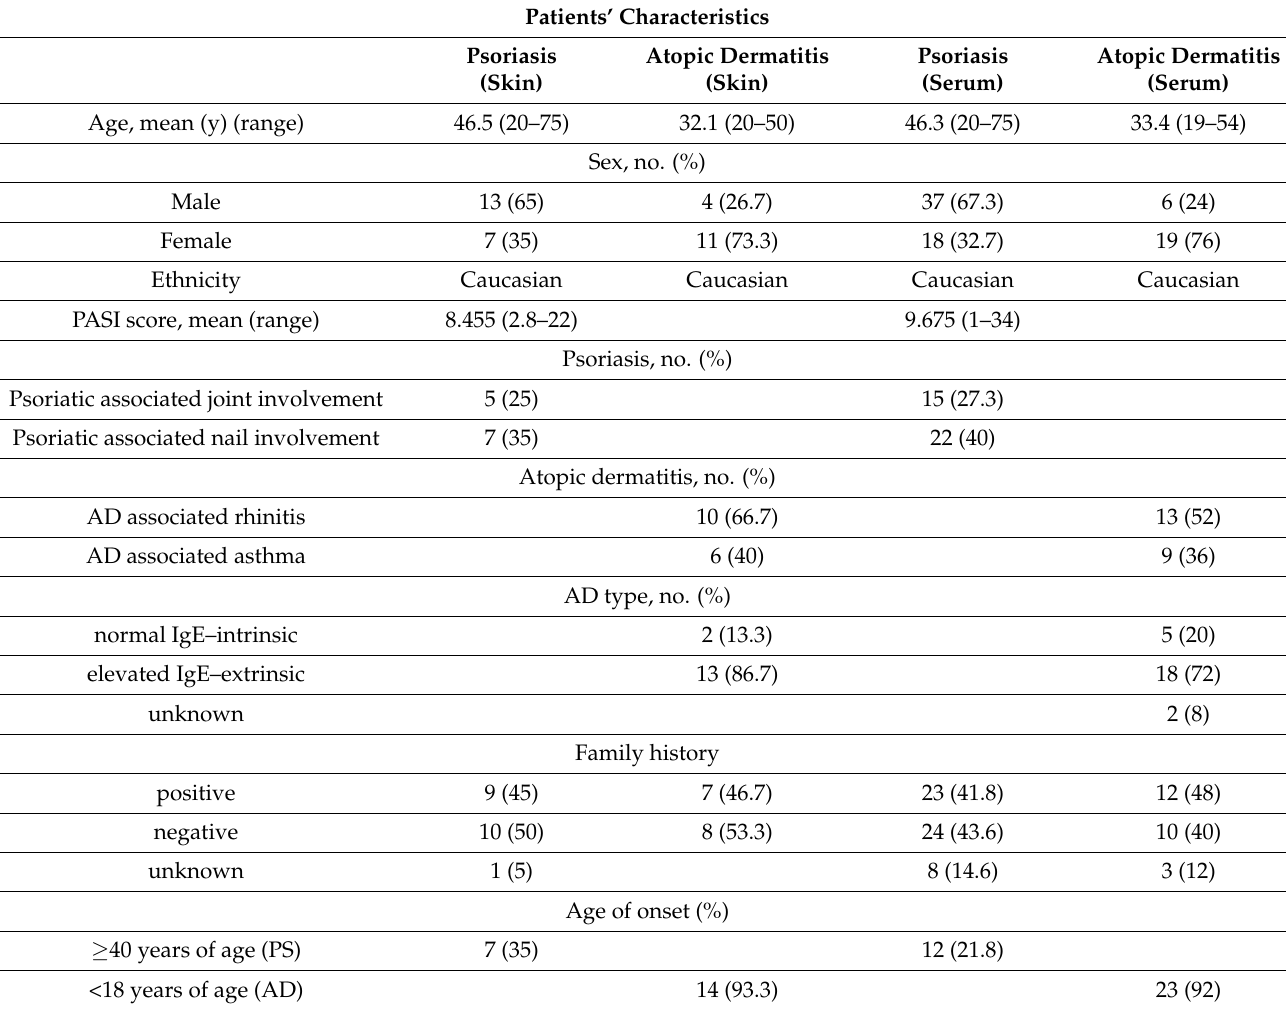
Table 3. Clinical and demographic characteristics of the patients’